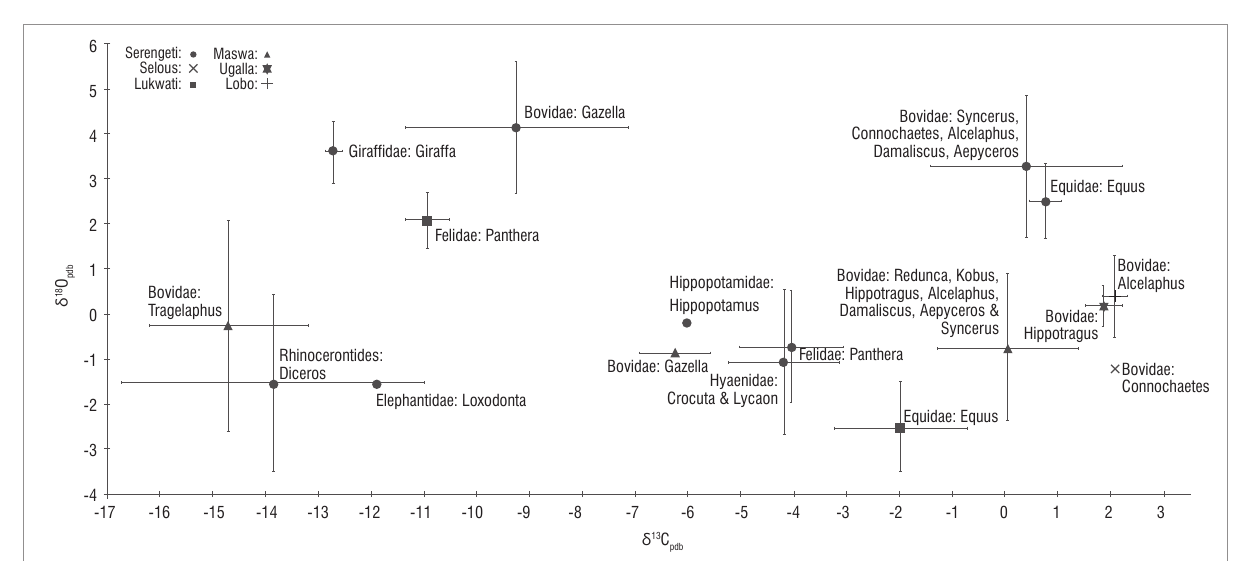
Figure 2: δ 13 C and δ 18 O values obtained from tooth enamel of fossil fauna from Olduvai Beds I and II.